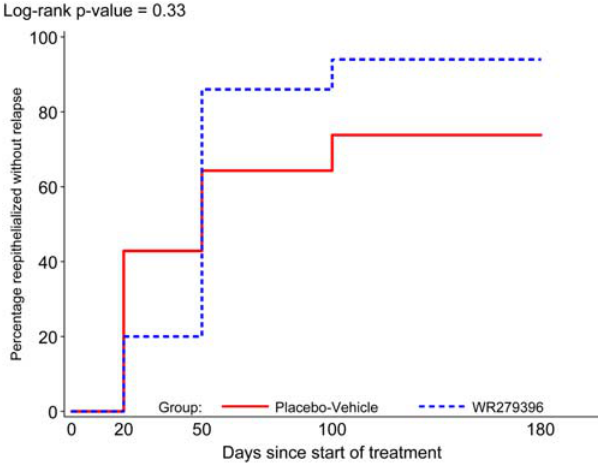
Figure 2. Reepithelialization of index lesion without relapse.